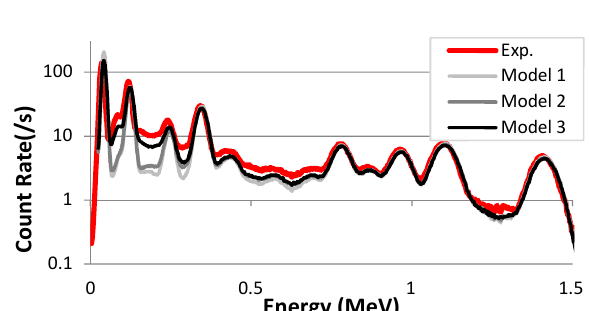
Fig 3. Comparison between experimental and simulated pulse height distributions of a Eu-152 source. A good agreement between simulated and measured energy spectra can be seen. While for the high-energy gamma rays the measured and calculated spectra match well, for the low- energy gamma-rays however a systematic difference and an under-estimation of the models are observed. The first one is due to non-proportional scintillation efficiency of the NaI(Tl) crystals at low energy region [7]. The scintillation efficiency is defined as the light output per unit deposited energy, is not a constant value and is not considered in MCNP6